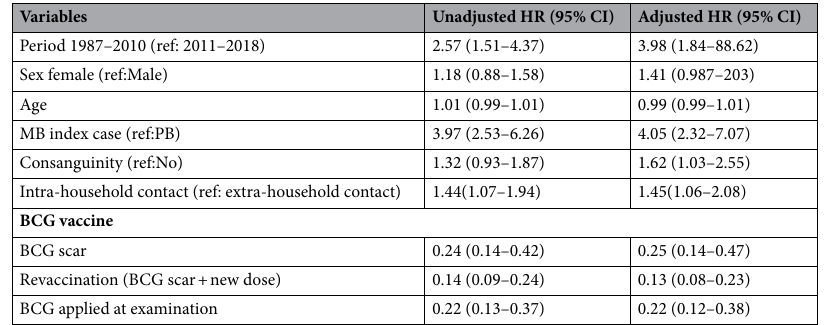
Table 2. Bivariate and multivariate analysis of the risk of disease outcome among contacts using Cox regression model. Cohort of contacts at the FIOCRUZ clinic, 1987–2018.